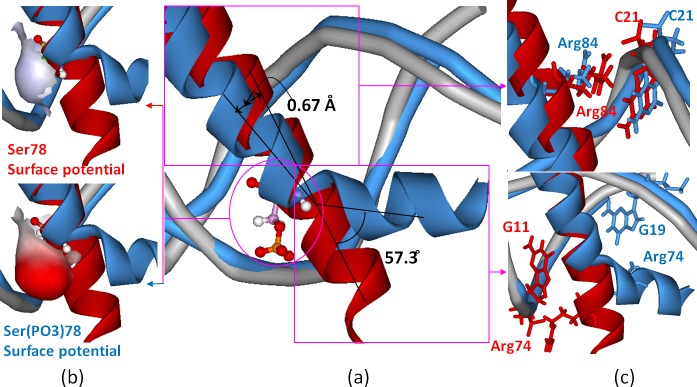
Conformation differences of the CbHLH+BbHLH+DNA and CbHLH+BPhos+DNA models.(a) The conformational difference of the H1B helix, (b) the different electrostatic surface potentials of the residue of Ser78/Ser(PO3)78, and (c) the different positions of the key residues in the CbHLH+BbHLH+DNA (red) and CbHLH+BPhos+DNA (sky blue) models.